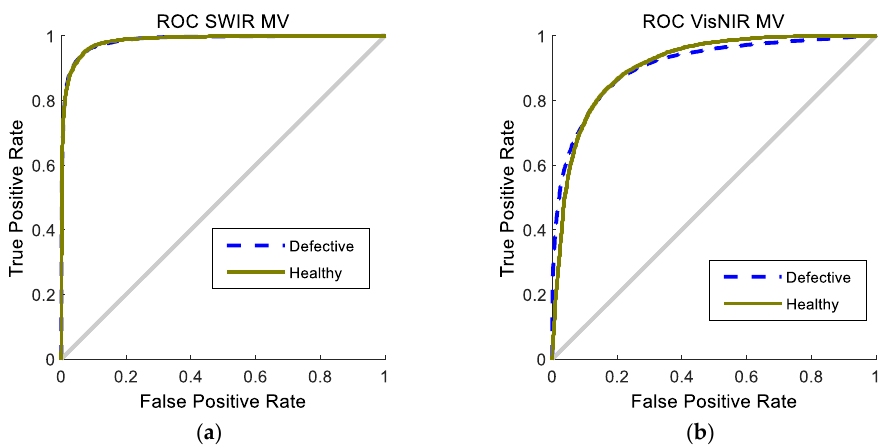
Figure 7. ROC curves of the MV classifier to classify potatoes in 200 iterations. ( a ) Using SWIR spectral range. ( b ) Using Vis/NIR spectral range.